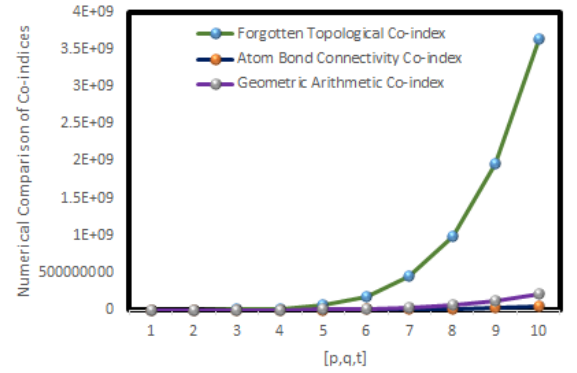
Figure 3: Comparison of F G ( ), ABC G ( ), and GA G (